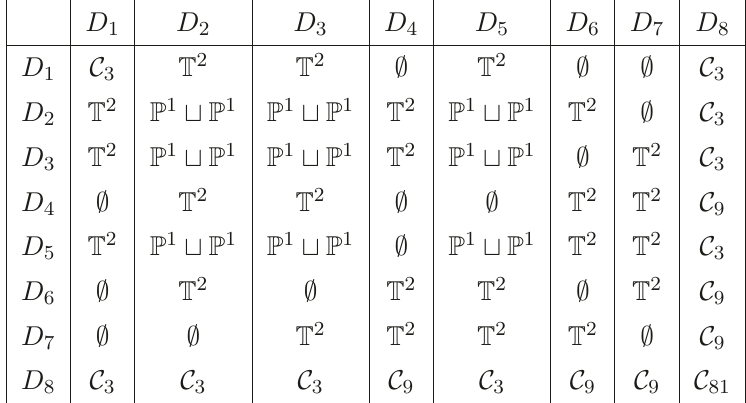
Table 1 . Intersection curves of two coordinate divisors. Here numbers h 0 , 0 = 1 and h 1 , 0 = g .